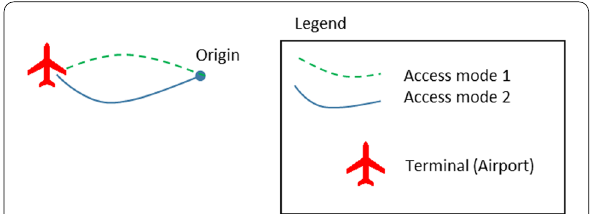
Fig. 1 Schematic figure of stand-alone access mode choice models (Type 1)